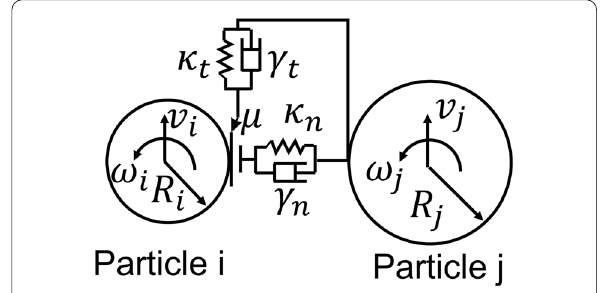
Figure 3 Scheme of the contact